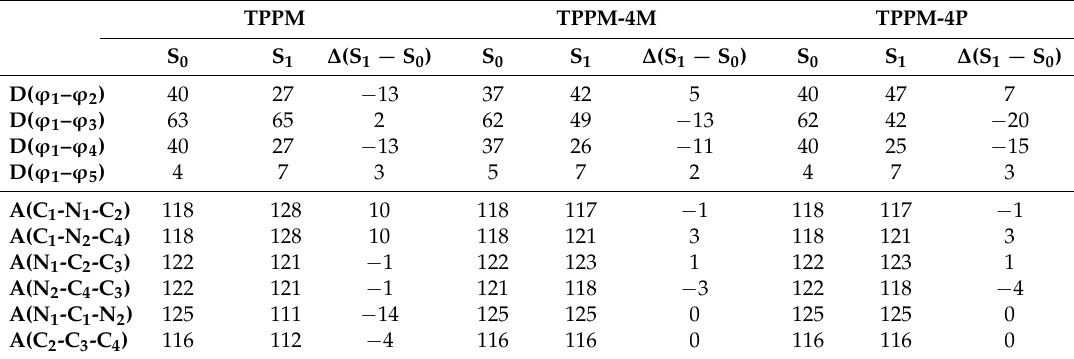
Table 1. Selected dihedral angles and bond angles (in degree) for isolated TPPM, TPPM-4M, TPPM-4P molecules in the S 0 and the S 1 state. TPPM TPPM-4M